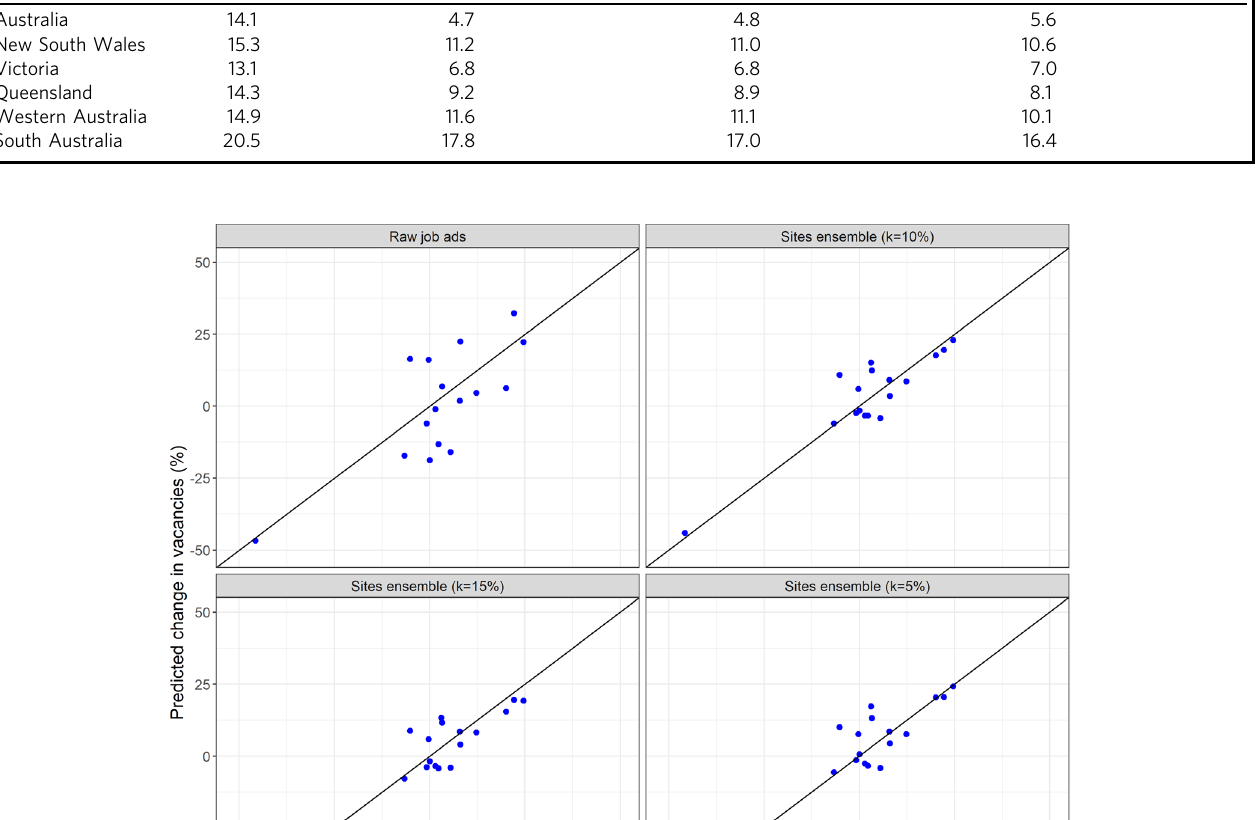
Table 2 The methods ’ mean absolute prediction errors across the 18 quarters from May 2018 to August 2022. Level of estimates